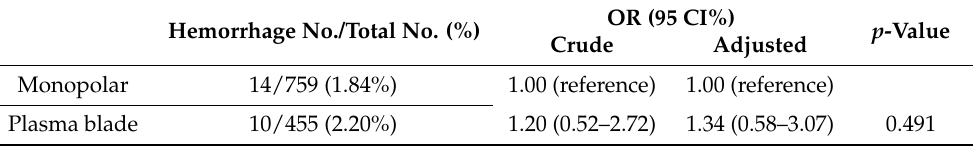
Figure 1. Postoperative hemorrhage rate. Table 2. Rates of postoperative